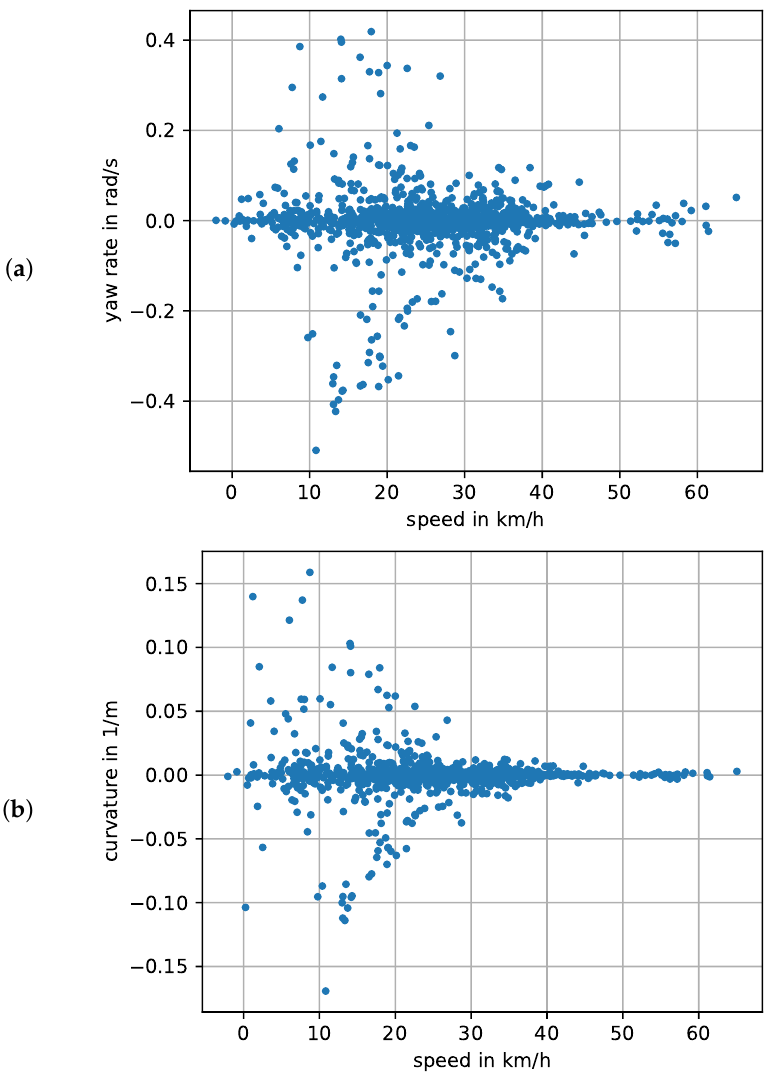
Figure 4. ( a ) Speed and yaw rate of all detected trims; ( b ) speed and curvature of all detected